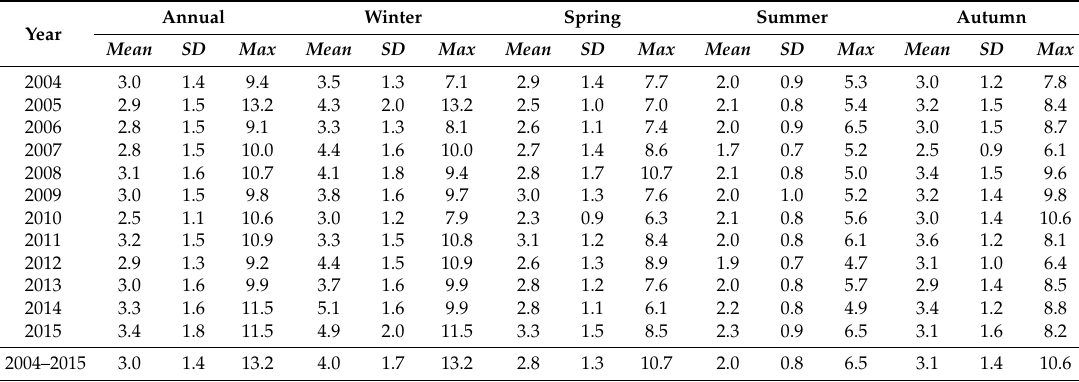
Table A2. Summary statistics from annual and seasonal analyses of H s (m) at